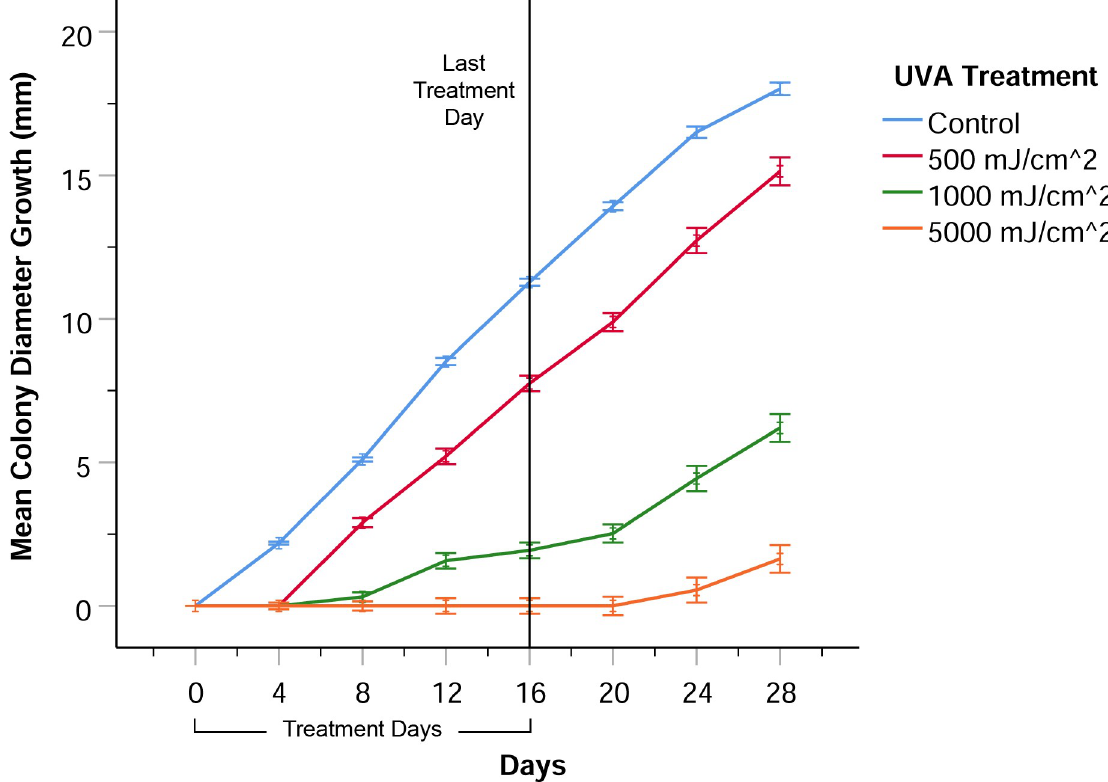
Fig 3. Pseudogymnoascus destructans colony growth with repeated methoxsalen and UVA exposure. Colonies were exposed to methoxsalen and UVA (365 nm) once every four days, for a total of five treatments. Ultraviolet A exposure inhibited growth of P . destructans colonies infused with methoxsalen in a UV dose-dependent manner. Control colonies received no UVA exposure or methoxsalen, or were exposed to either UVA or methoxsalen. Results were derived from eight biological replicates. Error bars represent one standard error of the